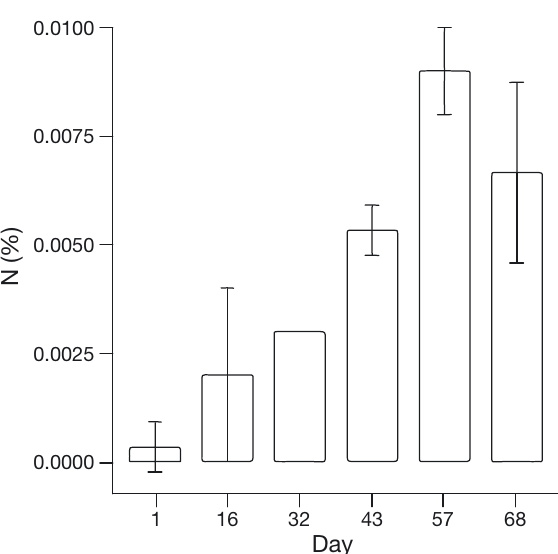
Fig. 6. Mean (±SD) nitrogen (N) content (% of dry weight) in the surface sediment of the sea cucumber tanks in the